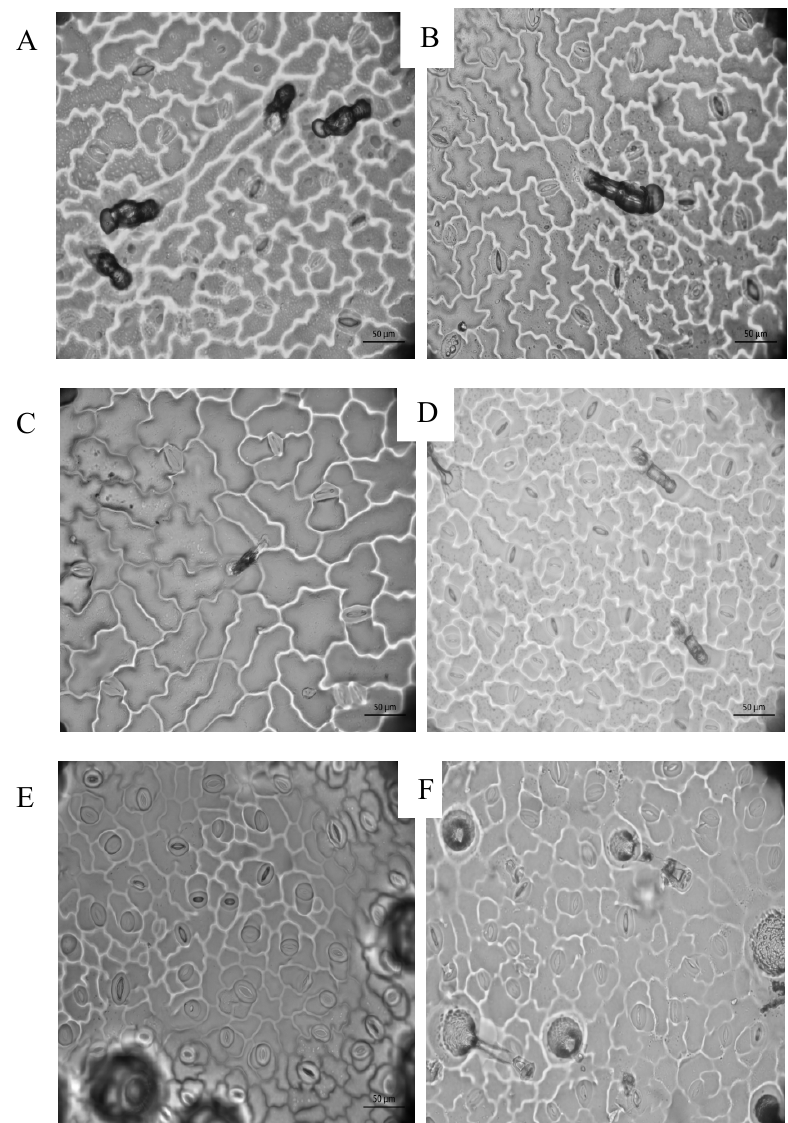
Figure 3. Epidermal cell imprints, stomata, glandular trichomes ( A , B ), and non-glandular trichomes ( E ) of domestic varieties (abaxial and adaxial), Serrano ( A , B ) and Yahualica ( C , D ), and a wild variety, San Javier ( E , F ) (40×).